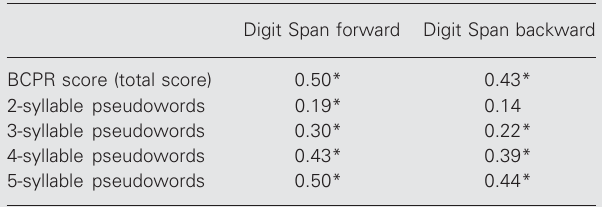
Table 4. Pearson correlations between BCPR and Digit Span by pseudoword length.